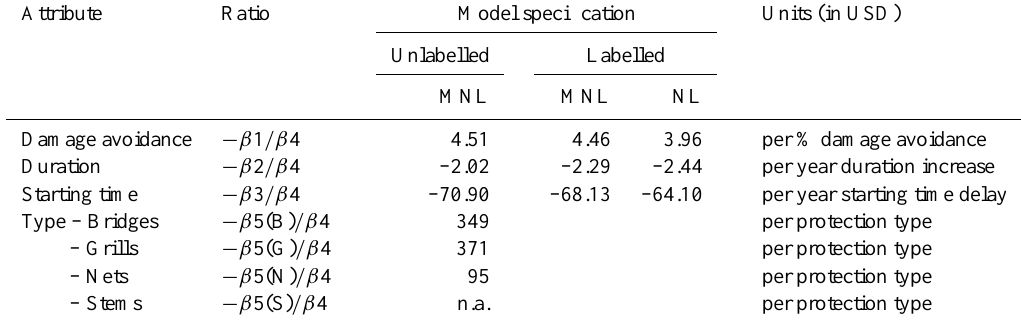
Table 3. Willingness to pay for a change in attribute levels and types. MNL=Multinomial logit; NL=Nested logit; n.a.=not available. Attribute Ratio Model specification Units (in USD)